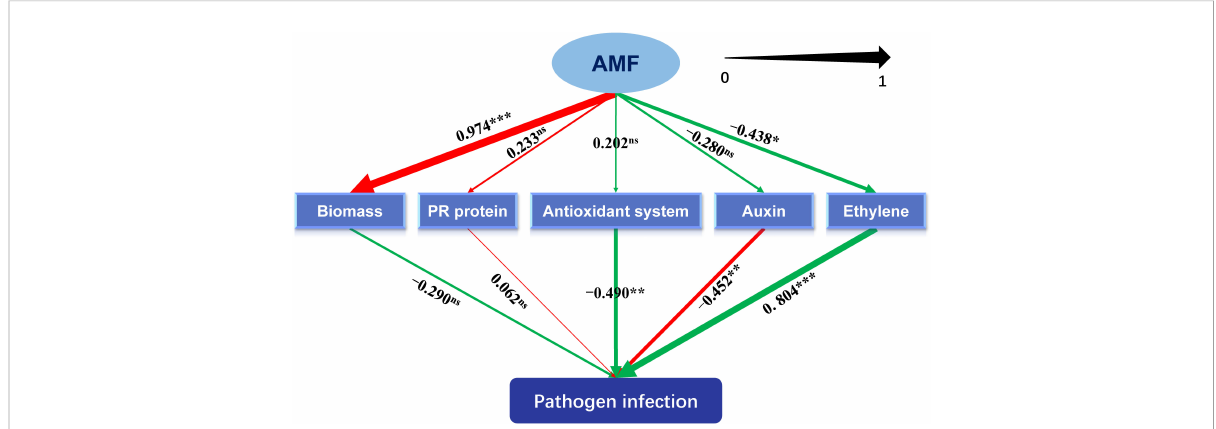
FIGURE 5 Schematic diagram of the partial least squares structural equation modeling (PLS-SEM). AMF: arbuscular mycorrhizal fungus. Path coef fi cients were shown and re fl ected in the width of the arrows. Positive effects are shown as red arrows, negative effects as green arrows. “‘ ***, ” “ **, ” "*" and “ ns ” means signi fi cance at p < 0.001, p < 0.01, p < 0.05 and non-signi fi cance,